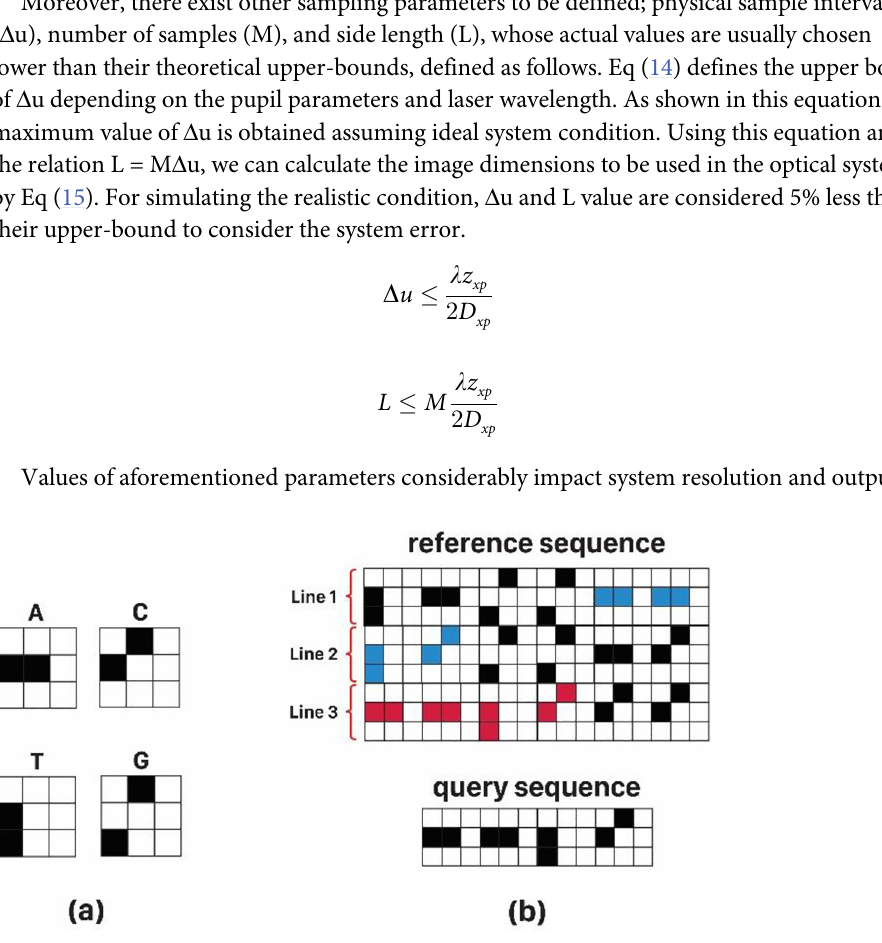
Fig 13. Example of cutoff error; a) coding set, b) "TAGGAATCGGACAATCCC" as the reference sequence is splitted into 3 lines with 6 codes, while "AATC" is th equery sequence. End of line 1 and begining of line 2 contain query sequence which is breaked from middle and it cannot be detected by the cross-correlation